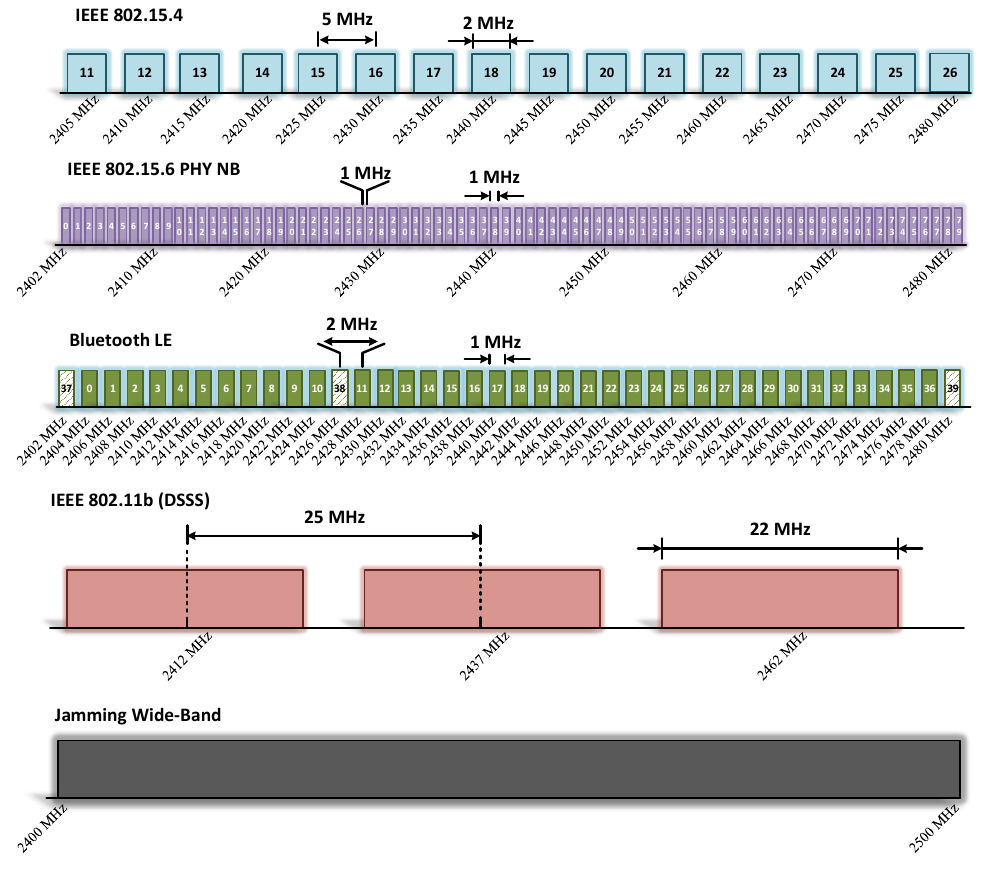
Figure 3. The wideband strategy can impact several channels and communications protocols in the ISM Band. In our work, we focus on analyzing the impact for a network using the IEEE 802.15.4